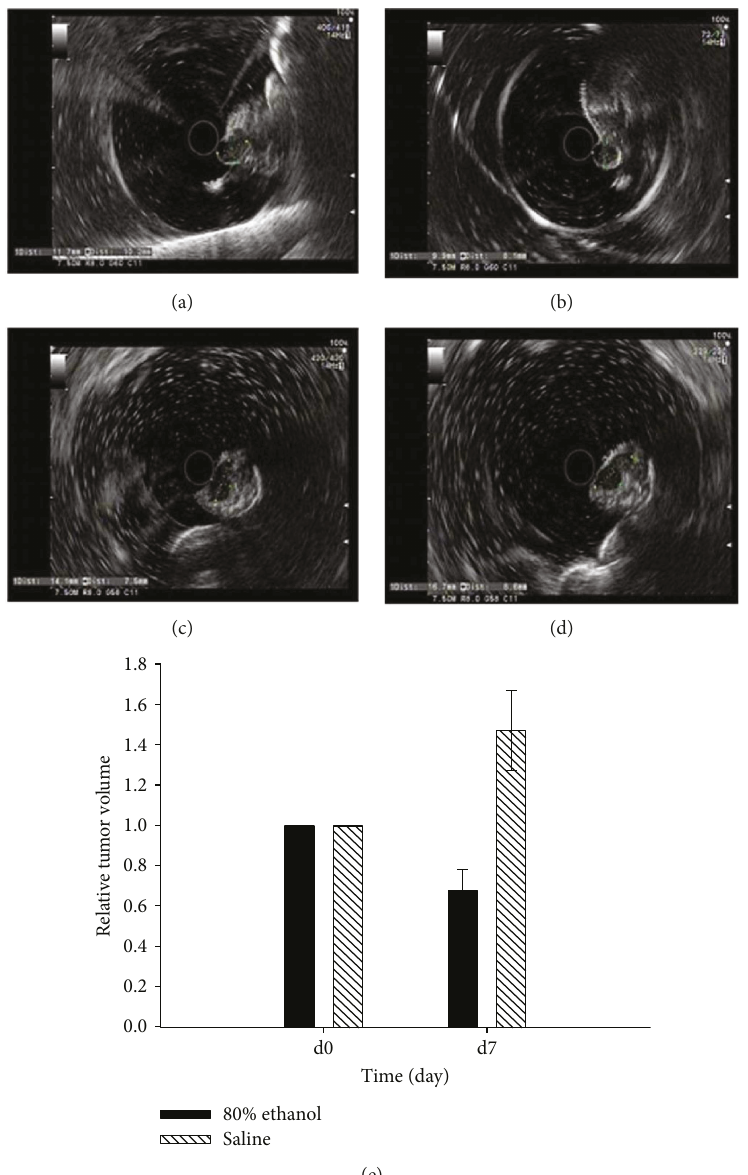
Figure 4: E ff ects of ethanol injection on the control of orthotopic pancreatic cancer cell mouse xenografts. (a) Tumor volume on day 0 after ethanol injection. (b) Tumor volume on day 7 after ethanol injection. (c) Tumor volume on day 0 after saline injection. (d) Tumor volume on day 7 after saline injection. (e) Summary of the